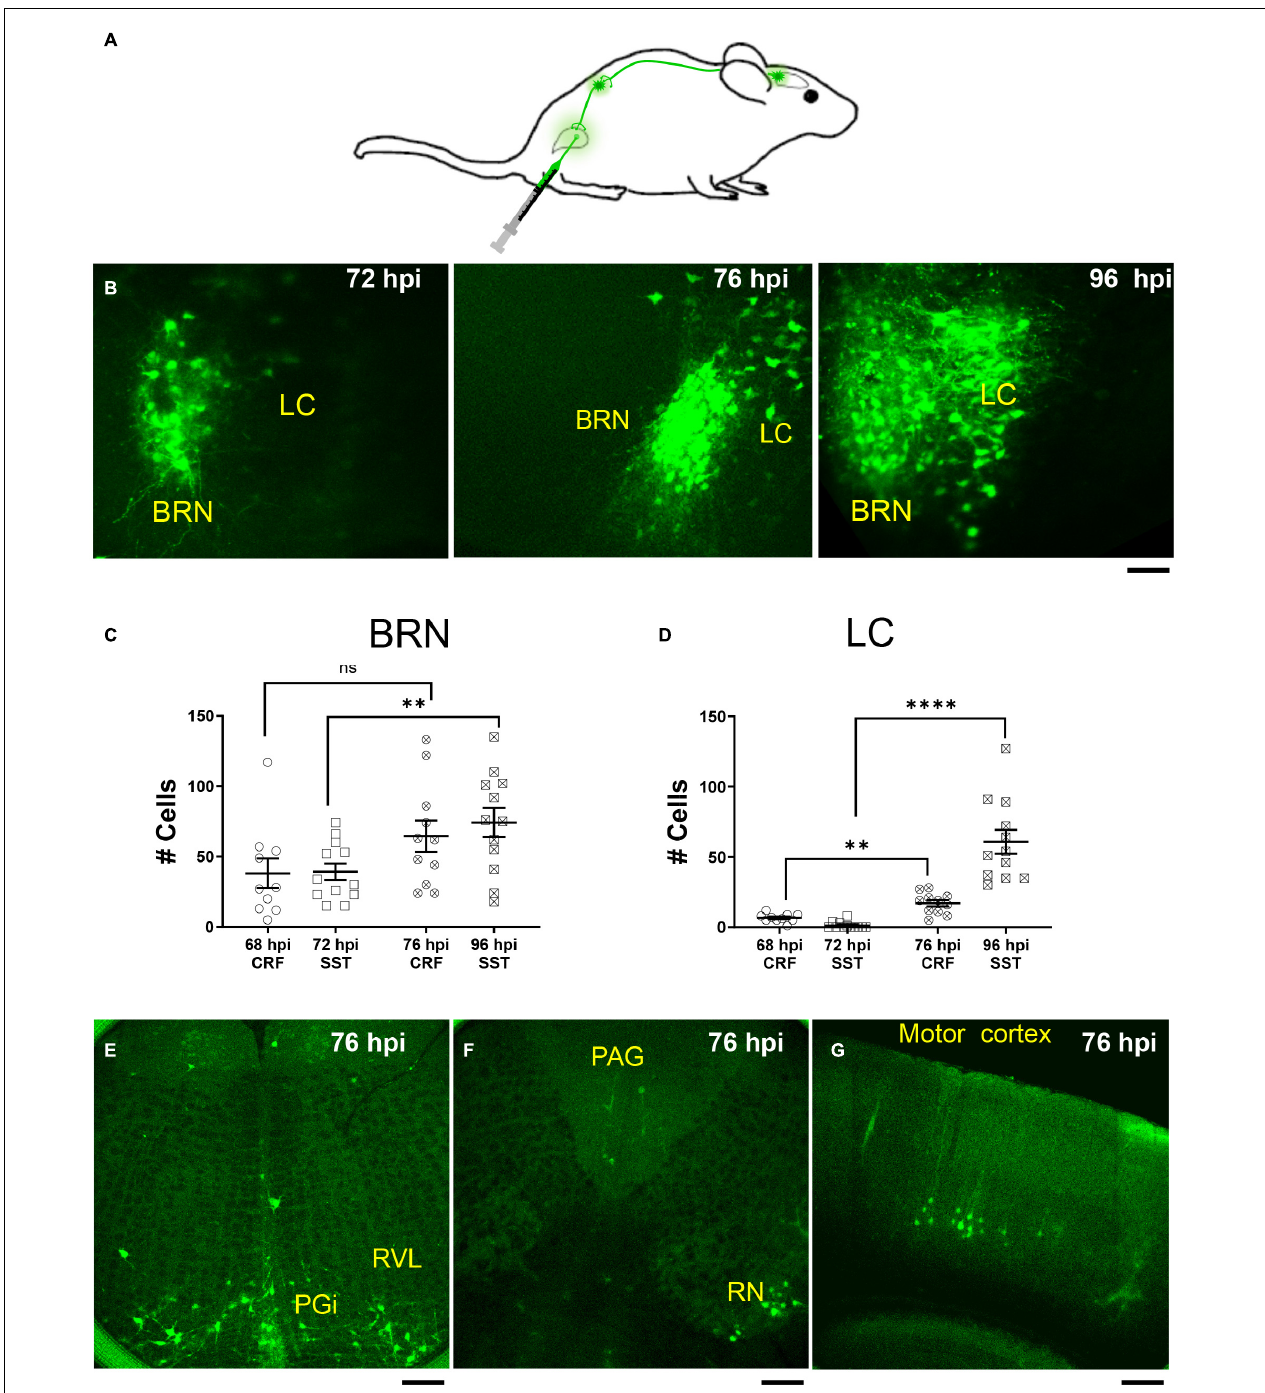
FIGURE 4 | PRV expression in BRN and LC after urinary bladder injections. (A) Schematic of injection and retrograde labeling pathway from bladder to brainstem of PRV-152 EGFP. (B) Example confocal z stack projections illustrating fluorescently labeled neurons in the pontine area following injection of the retrograde trans- synaptic tracer, PRV-152 EGFP into the detrusor muscle of the urinary bladder after 72 h ( left ), 76 h ( middle ), and 96 h ( right ) post injections (hpi, hours post injections). Scale bar = 100 µ m. (C) Summary of the result of PRV labeled cell count in the BRN (68 hpi CRF BRN: empty circles, n = 1 mouse, 4 slices, 10 BRN areas, 38 ± 11 cells; 72 hpi SST BRN: empty squares, n = 2 mice, 5 slices, 12 BRN areas, 39 ± 6 cells; 76 hpi CRF BRN: crossed circles, n = 1 mouse, 3 slices, 11 BRN areas, 65 ± 11 cells; 96 hpi SST BRN: crossed squares, n = 2 mice, 6 slices, 12 BRN areas, 74 ± 10 cells). (D) Summary of the result of PRV labeled cell count in the LC (68 hpi CRF LC: empty circles, n = 1 mouse, 4 slices, 10 LC areas, 6.7 ± 0.96 cells; 72 hpi SST LC: empty squares, n = 1 mouse, 5 slices, 12 LC areas, 1.3 ± 0.72 cells; 76 hpi CRF LC: crossed circles, n = 1 mouse, 4 slices, 11 LC areas, 17 ± 2.3 cells; 96 hpi SST LC: crossed squares, n = 2 mice, 6